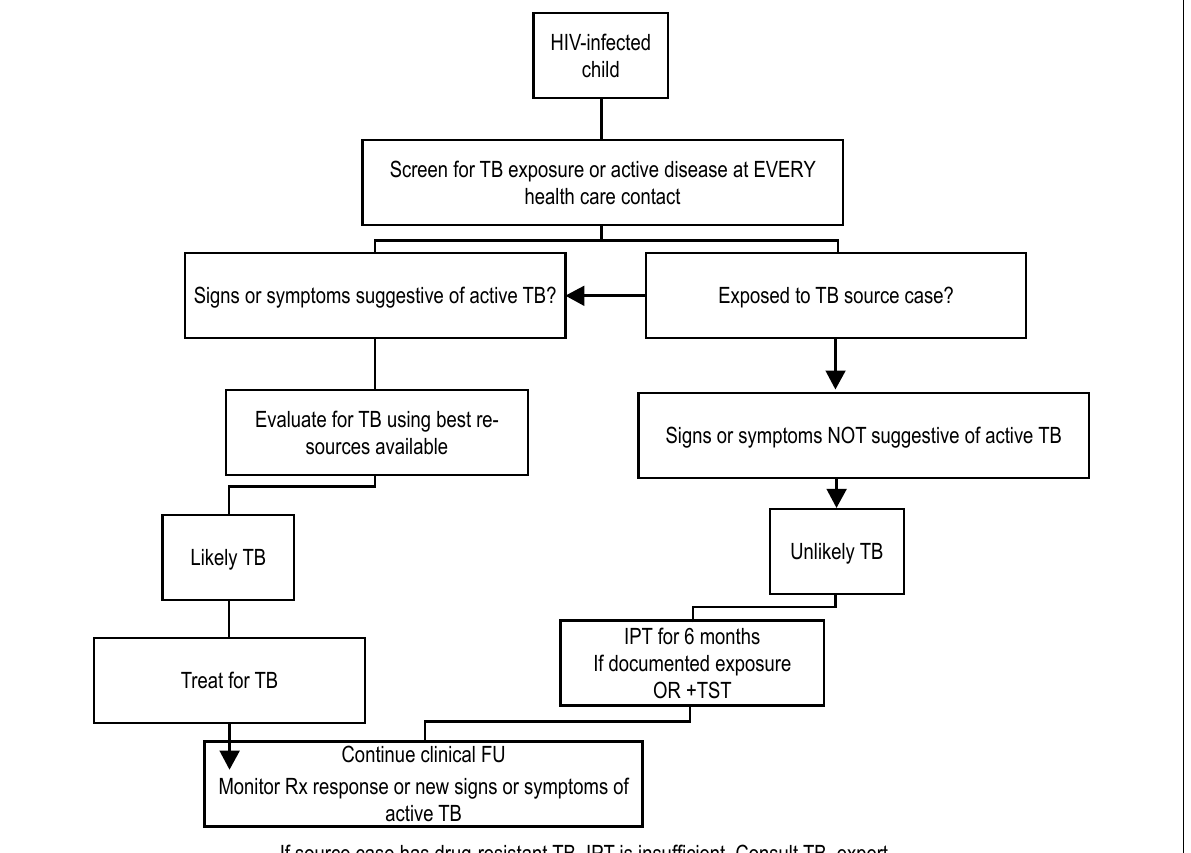
Fig. 1. Management of an HIV-infected child with documented TB exposure or suspected to have TB